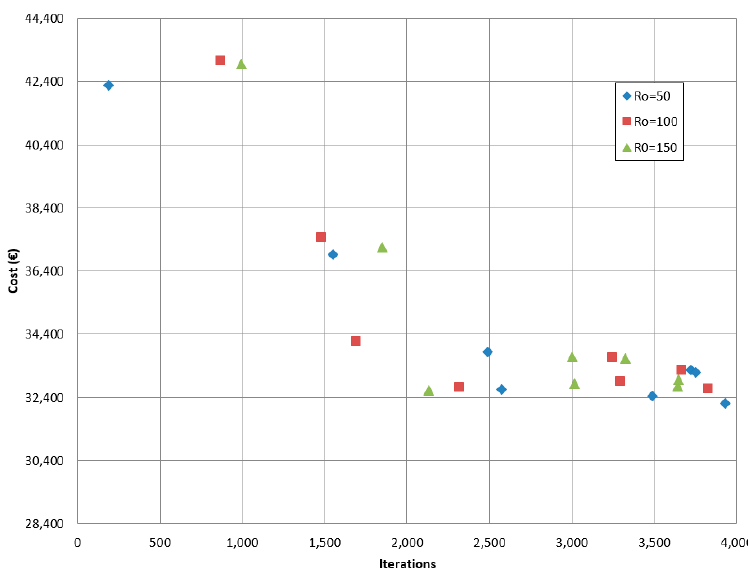
Figure 6. Average cost to average iterations for the glow-worms swarm optimization (GSO) experiment.